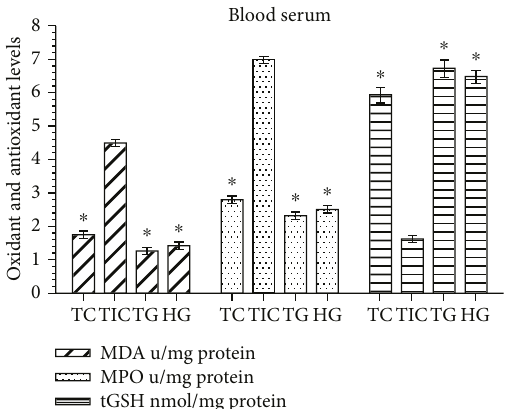
Figure 1: MDA, MPO, and tGSH levels in blood serum of the study groups. TC, TG, and HG groups were compared with the CIS group ( n = 6 , ∗ P < 0 0001 ).